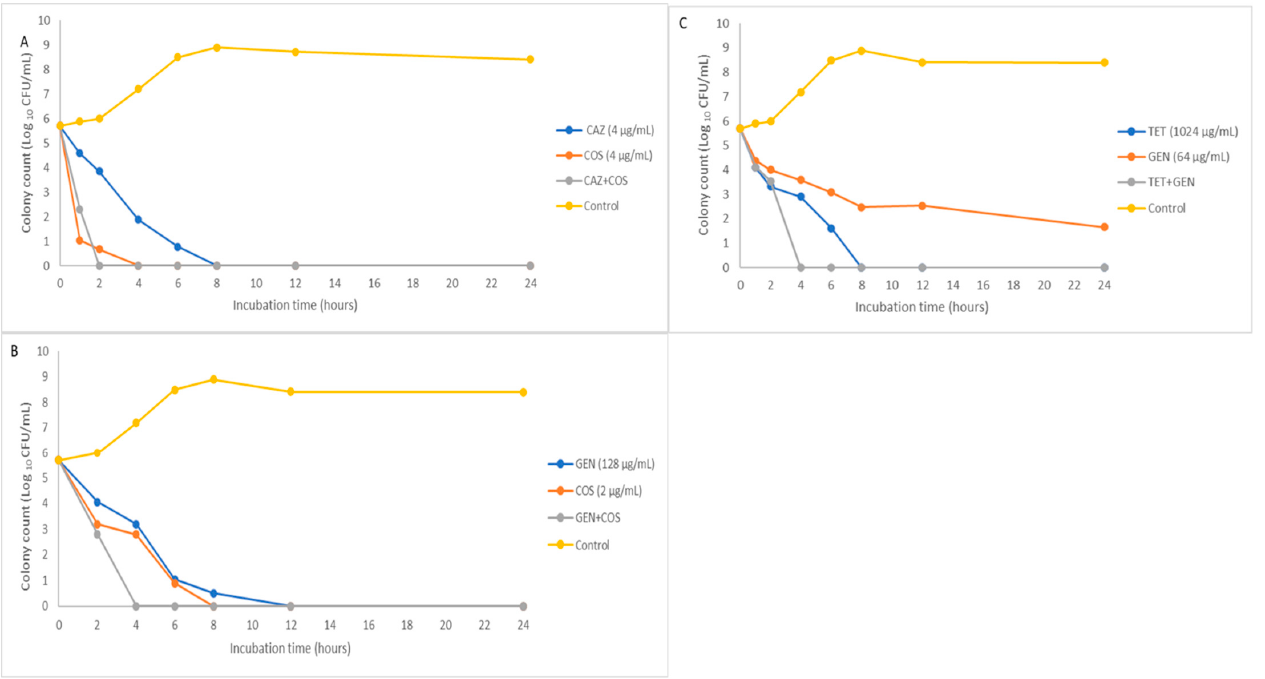
Figure 2. Time–kill curves for antimicrobials in combination at various minimum inhibitory con ‐ centration (MIC) values against multidrug ‐ resistant MDR C. freundii. ( A , B ) The combination of col ‐ istin at MIC in combination with ceftazidime and gentamicin against isolates C2 and C4, respec ‐ tively. ( C ) Drug combination between gentamicin and tetracycline against isolate C4.